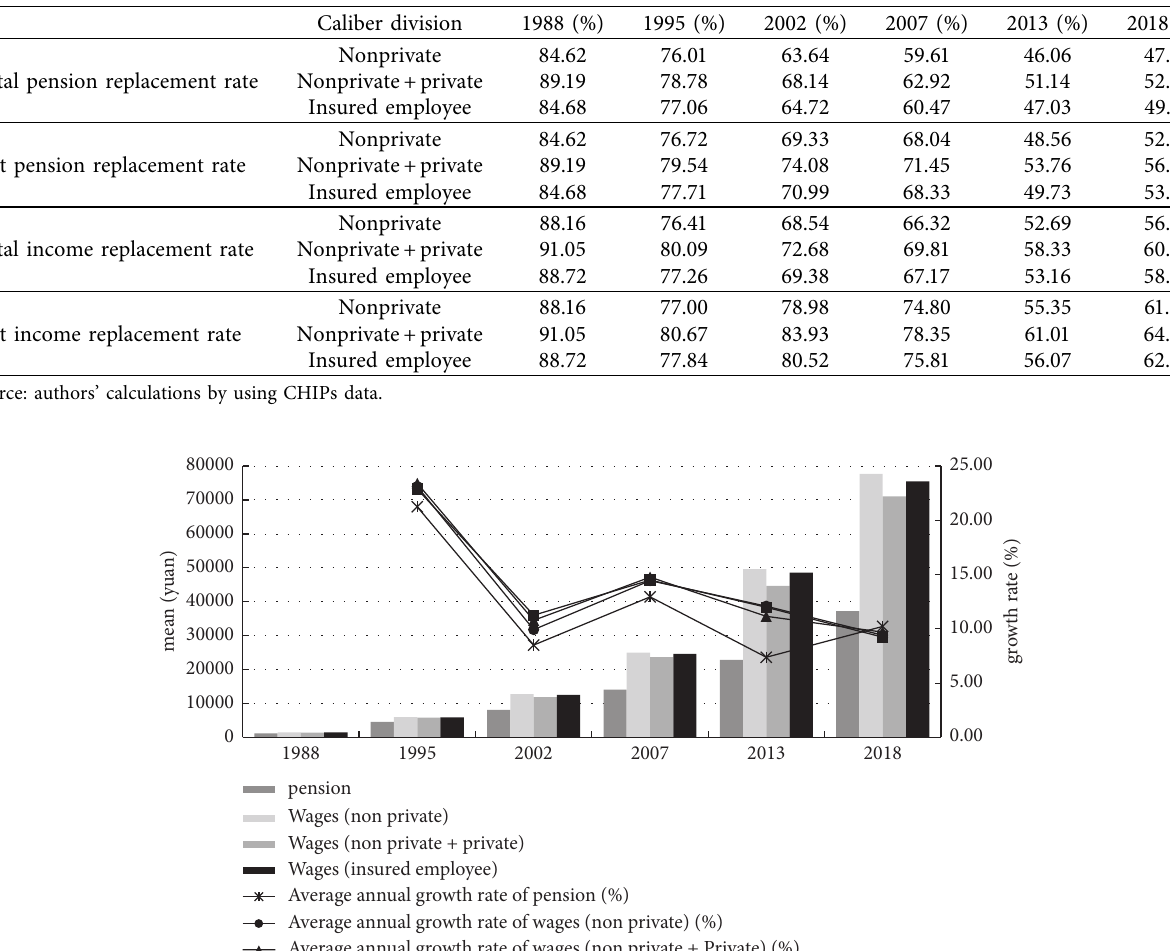
Table 2: Pension replacement rate and income replacement rate of urban employees in